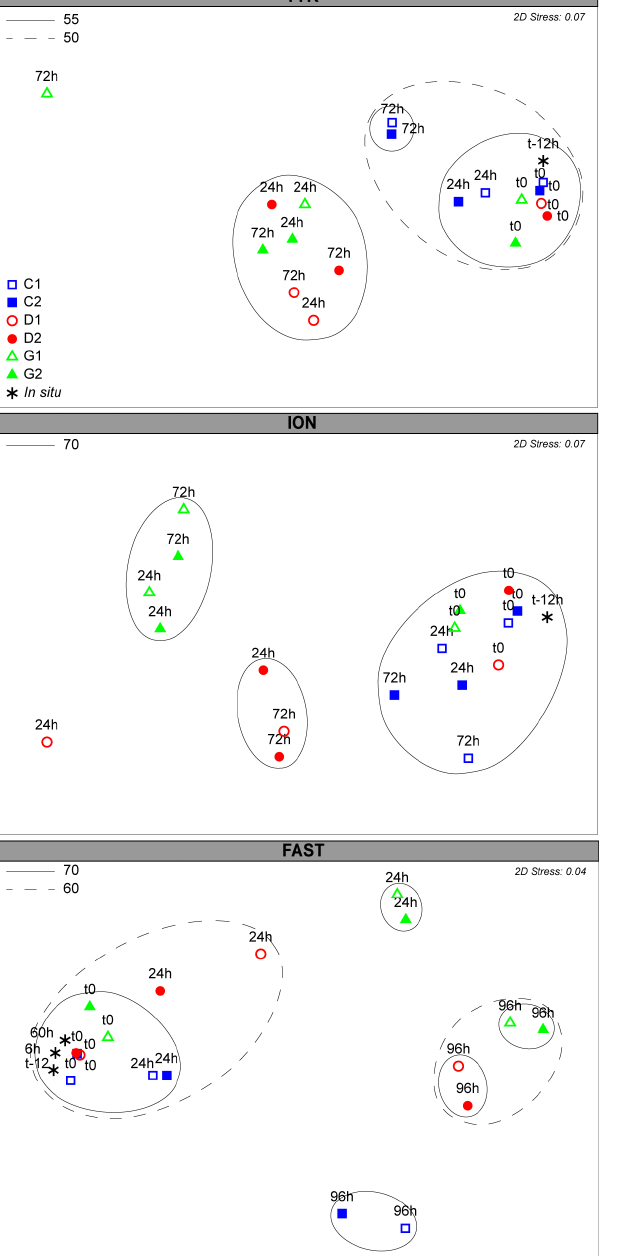
Figure 6. NMDS plot of the microeukaryotes community composi- tion over the course of the three experiments based on Bray–Curtis dissimilarities of 18S rDNA sequences. Samples clustering at dif- ferent levels of similarity are circled together. All circles represent clusters which are significantly different ( p< 0 . 05) from each other based on a PERMANOVA